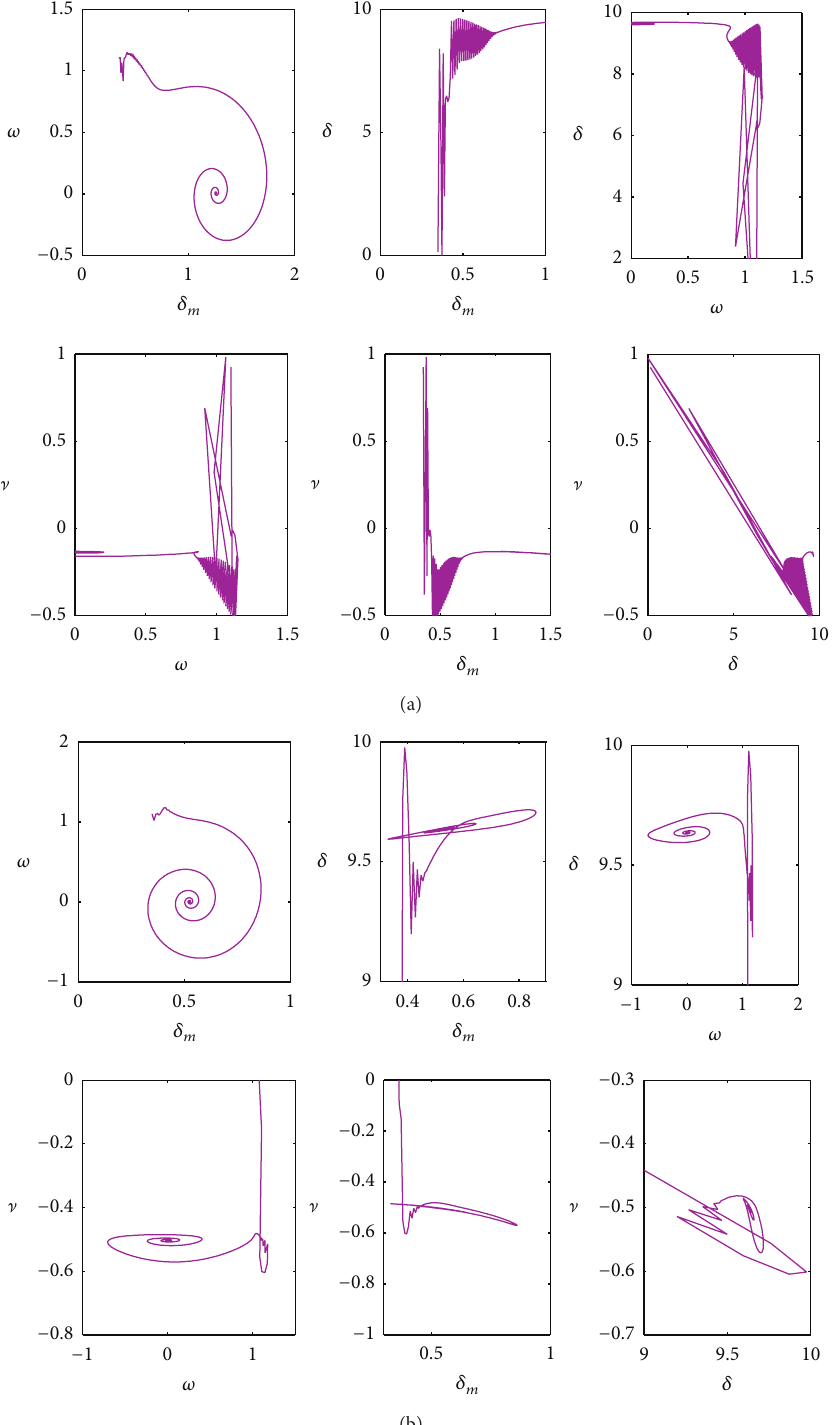
Figure 4: The 2D trajectory in the fractional-order power system with 𝑞 𝑖 = 0.9 , 𝑖 = 1, 2,3, 4 . (a) 𝑄 1 = 1 ; (b) 𝑄 1 = 5.9